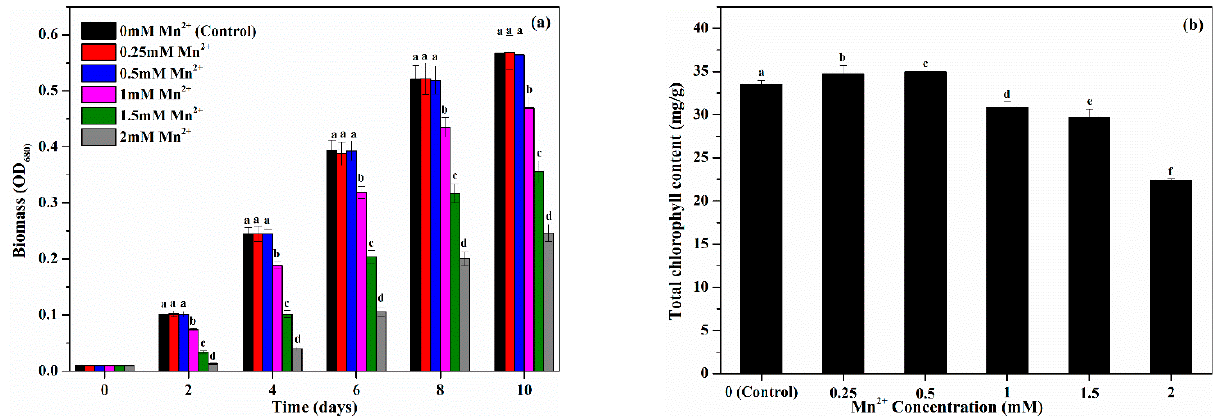
Figure 1. Effect of Mn 2+ on ( a ) the mixed MnOMs growth, and ( b ) the total chlorophyll content after 10 days of cultivation. The different letters above the error bars showed significant differences between control and treatment ( p < 0.05).